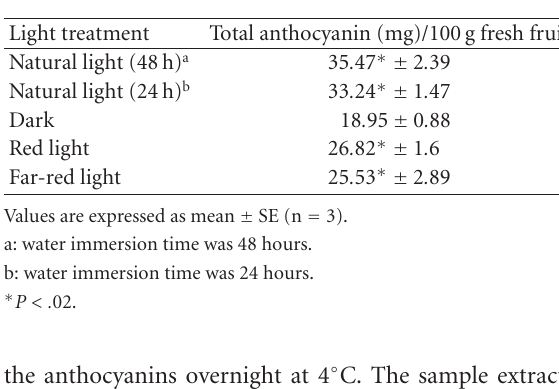
Table 1. E ff ect of light on total anthocyanin level in submerged, harvested cranberry